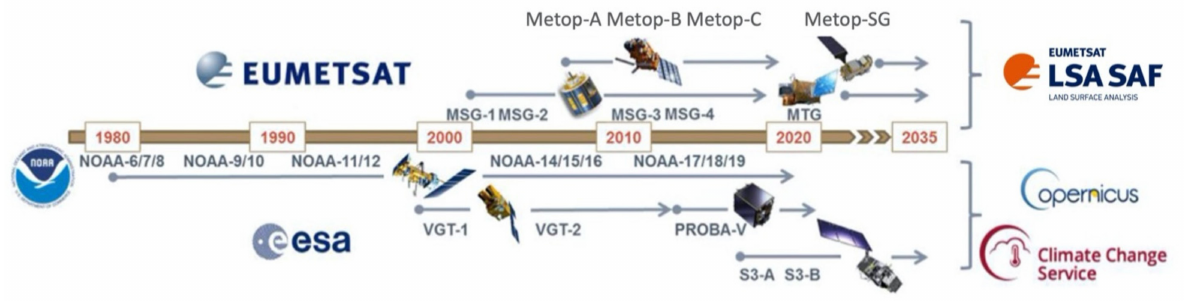
Figure 11. Flowchart of the satellite missions used for the retrieval of the surface albedo products using the M é t é o France algorithm presented in this